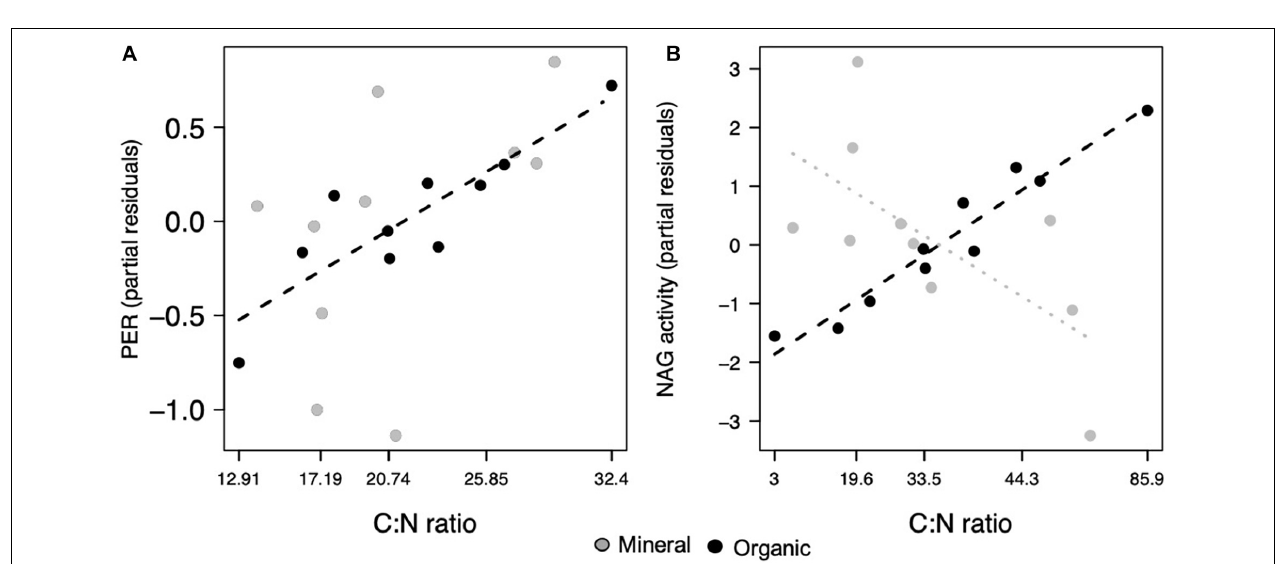
FIGURE 4 | Microbial functions responded to the ratio of carbon to nitrogen (C:N), where peroxidase increased in both horizons and (A) NAG decreased in the mineral and (B) increased in the organic horizon. Points represent the partial residuals of response variables plotted against C:N. Dashed lines represent individual horizon responses where the mineral horizon is represented by gray and the organic horizon, black lines ( p < 0.05). Dotted lines represent marginally significant relationships ( p <